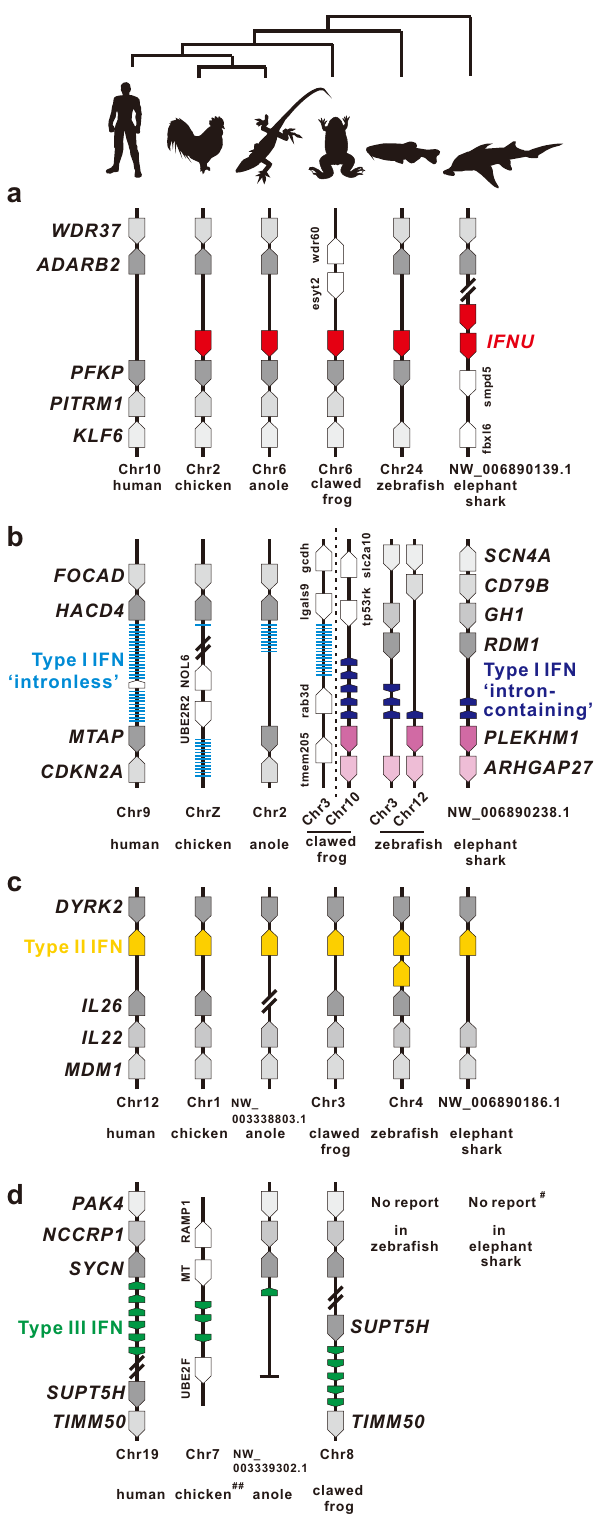
and functionally characterized in zebra fi sh and clawed frog. IFN- υ shares several typical features with known IFNs. Firstly, this IFN- υ protein in zebra fi sh as well as in other vertebrates has a similar number of amino acids being about 200 with other known IFN proteins (about 200 aa), and has a signal peptide and six putative alpha helices, as type I, type II and type III IFNs with fi ve to six helices, respectively. Secondly, IFN- υ genes share same